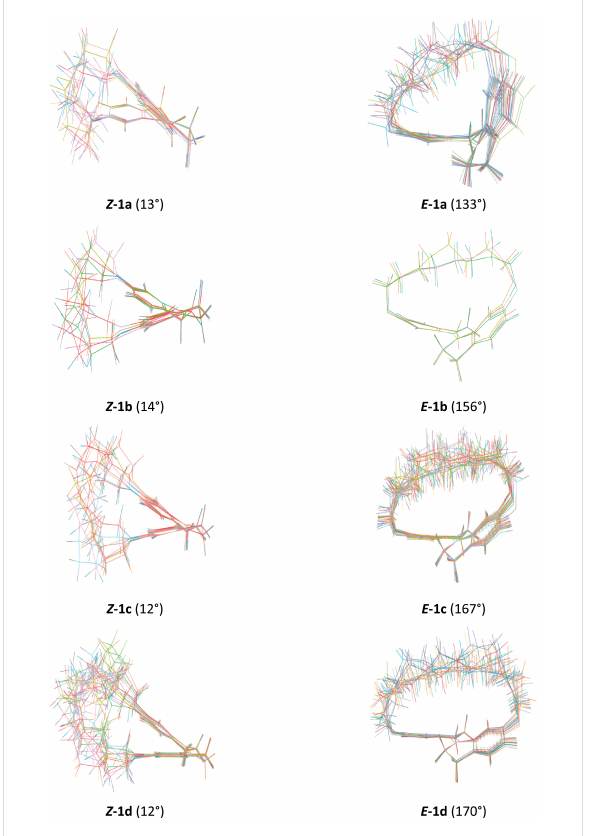
Figure 6: Conformer ensembles for the macrocyclic stiff stilbene diethers 1a – d . Dihedral angles between the two aromatic rings are given in